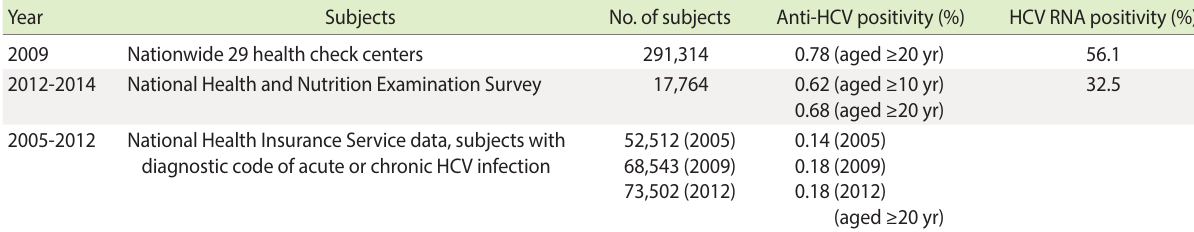
Table 1. The prevalence of hepatitis C virus (HCV) infection in